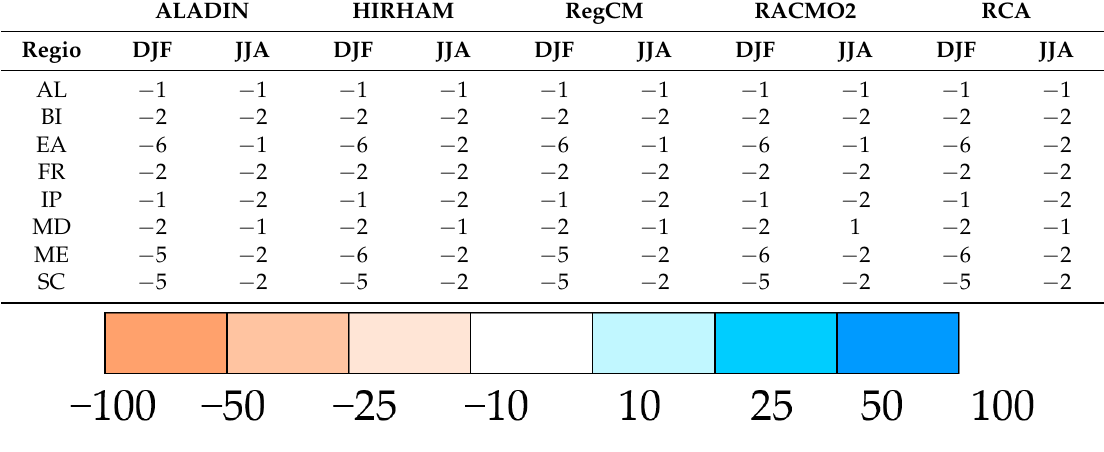
Table 6. Residual bias of the seasonal amount of simulated precipitation in the case of local intensity scaling of the precipitation bias correction method in eight different regions: the Alps (AL), the British Isles (BI), Eastern Europe (EA), France (FR), the Iberia Peninsula (IP), the Mediterranean (MD), Mid-Europe (ME) and Scandinavia (SC) in DJF and JJA. The bias values are in %. ALADIN HIRHAM RegCM